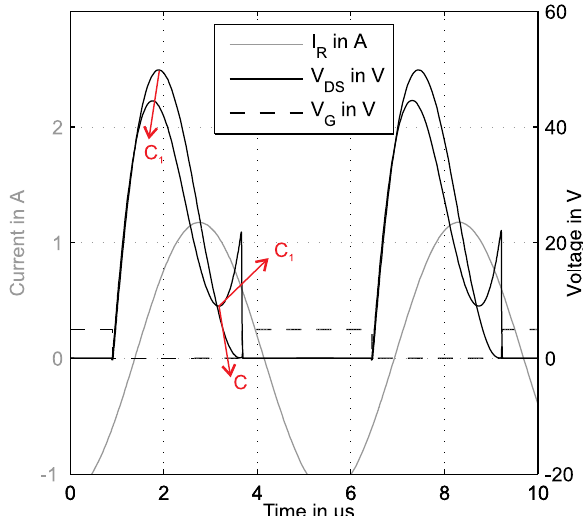
Figure 6. Simulations of a tuned and a mistuned amplifier. The arrows indicate the direction into which the minimum moves when changing the values for C and C 1